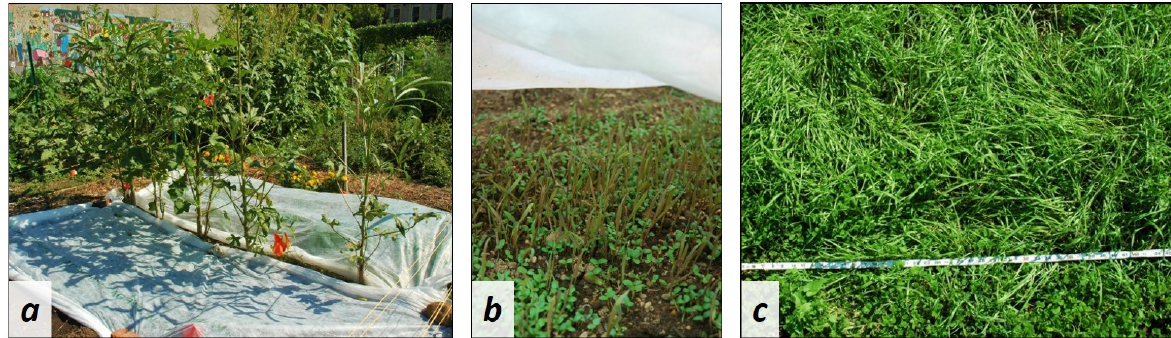
Figure 1. Innovation in Cover Crop Planting Practice Suggested by a Farmer Field School Gardener The innovation was protecting newly planted plots with row cover to prevent seed predation by birds. (a) Row cover over newly planted cover crop seed in a community garden, Fall 2012. (b) Cover crop seed germinating under row cover. (c) Well-established rye ( Secale cereale ) and crimson clover ( Trifolium incarnatum ) mixture, three weeks after